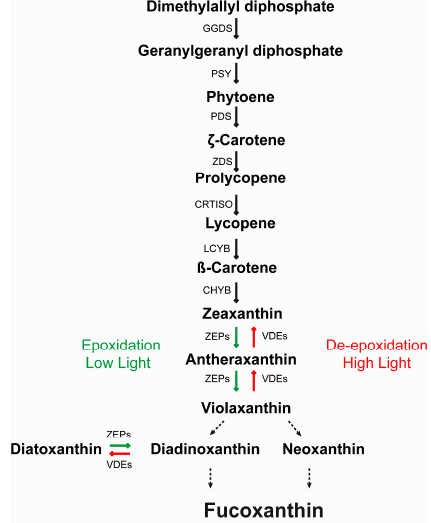
Figure 1. Schematic representation of the carotenoid biosynthesis pathway in P. tricornutum , according to the hypothesized pathways proposed by Lohr and Wilhelm 1999 [20] and Dambek et al. 2012 [21]. Dashed lines are used for unknown enzymes. Red arrows represent de-epoxidation reactions and green arrows represent epoxidation reactions operating in the two xanthophyll cycles. GGDS: geranylgeranyl diphosphate synthase; PSY: phytoene synthase; PDS: phytoene desaturase; ZDS: ζ -carotene desaturase; CRTISO: carotene cis/trans isomerase, prolycopene isomerase; LCYB: lycopene cyclase b; LUT: lutein deficient-like; ZEP: zeaxanthin epoxidase; VDE: violaxanthin de-epoxidase. Adapted from M. Bertand et al. (2010) and P. Kuczynska et al. (2015) [9,19]. Attempts to overexpress the 1-deoxy- D -xylulose 5-phosphate synthase ( Dxs ), the gateway enzyme of the terpenoid pathway, or the Phytoene synthase ( Psy ), controlling the initial step of the carotenoid biosynthesis, resulted in a moderate increase in fucoxanthin content [22,23].